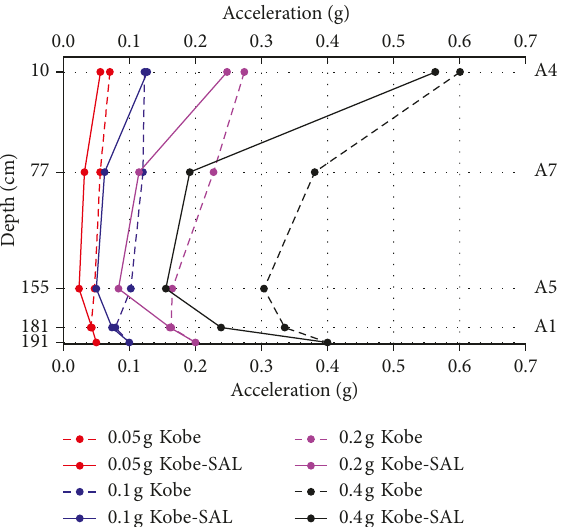
Figure 13: Comparison of profiles of max Kobe acceleration with SAL and without tests.